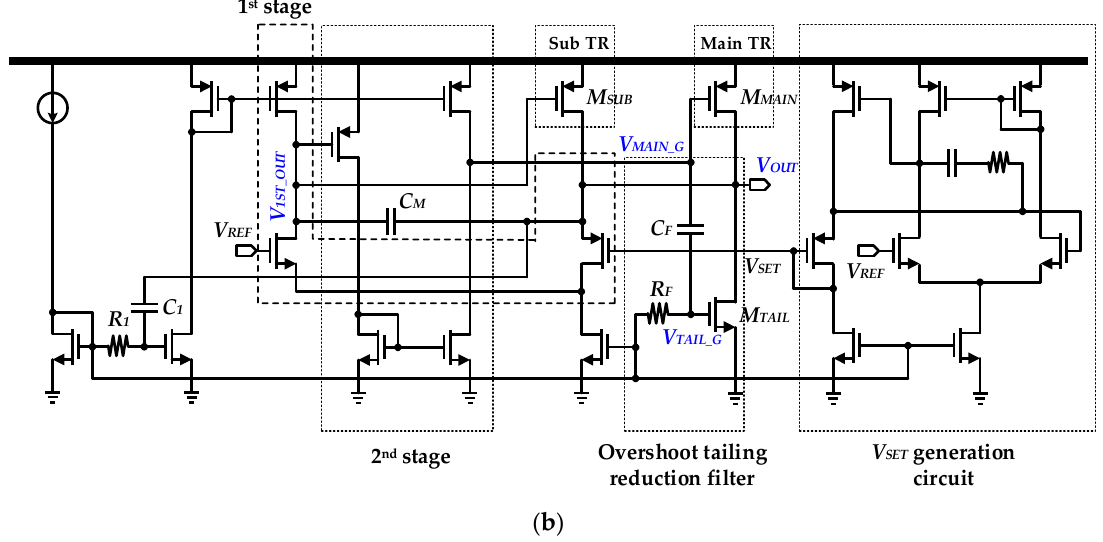
Figure 7. Full schematic representations of LDO regulators: ( a ) loop gain enhanced FVF-based LDO regulator [15] and ( b ) proposed LDO regulator.